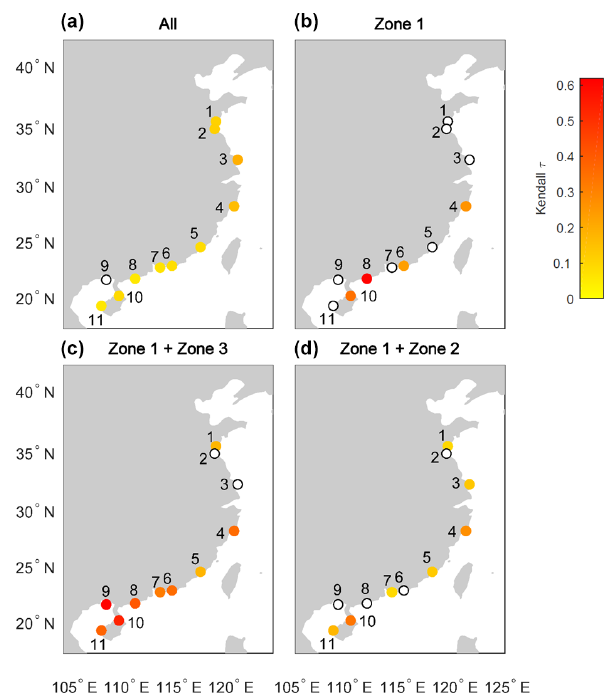
Figure 3. Kendall dependence between storm surge and precipita- tion. (a) Daily maximum storm surge and daily cumulative precip- itation; (b) pairs in Zone 1; (c) pairs in Zone 1 + Zone 3; (d) pairs in Zone 1 + Zone 2. (b–d) The maximum dependence for thresh- olds running from 95% to 99.5%. White dots refer to insignificant dependence (10%